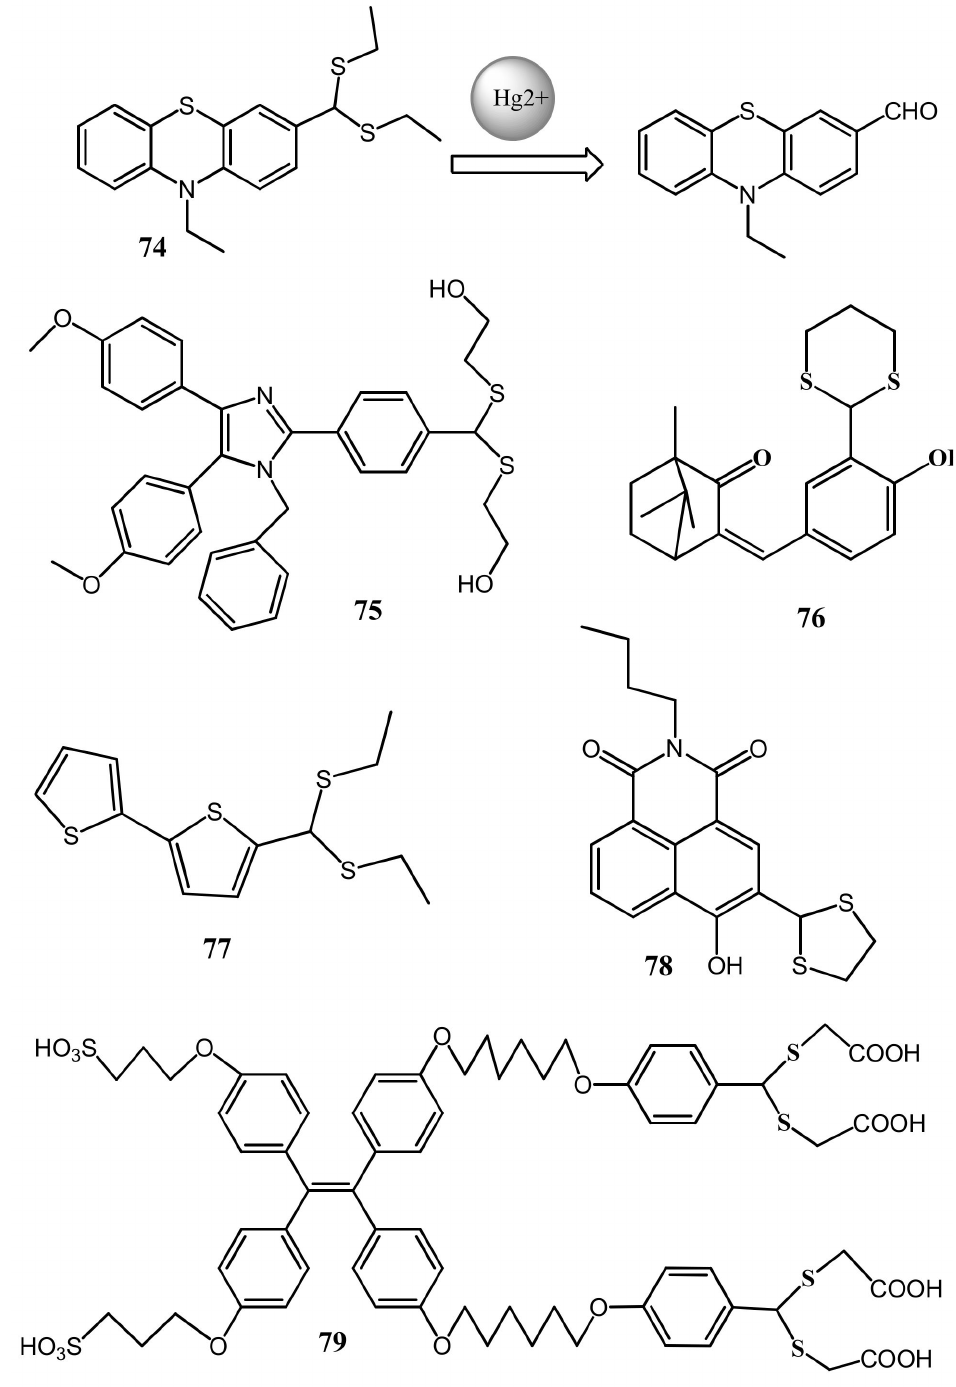
Figure 25. Molecular structures of the sensors 74 to 79